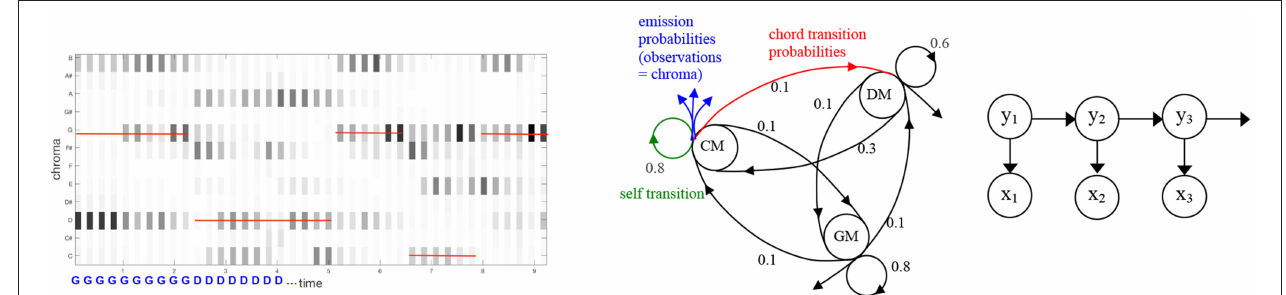
FIGURE 2 | (Left) Example of half-beat-synchronous chromagram computed in the beginning of Mozart piano sonata KV.283 and corresponding ground truth chord transcription. Chords changes on half measures, and chroma features belonging to the same half measures contain similar content. (Middle) In general, each chroma feature is used independently to train a HMM. (Right) Graphical model of a HMM describing the joint probability distribution p ( y , x ) for a sequence of three input variables x